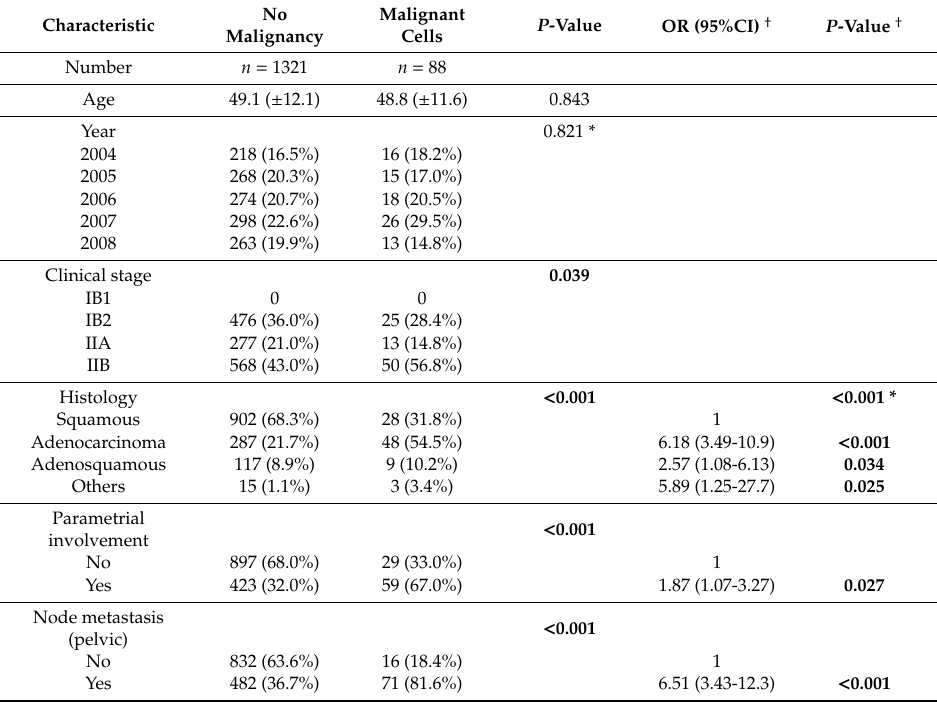
Table 2. Patient demographics based on peritoneal cytology results ( n =